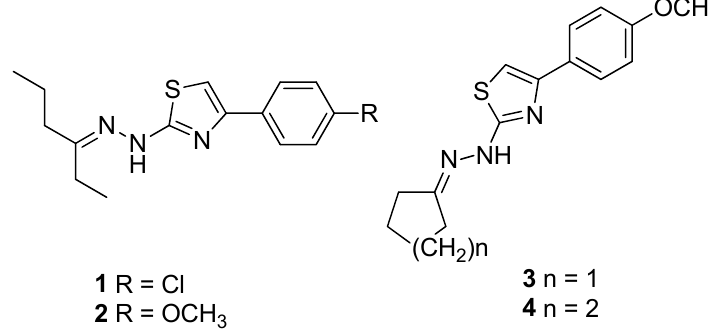
Figure 1. Chemical structure of thiazolylhydrazones 1 – 4 .